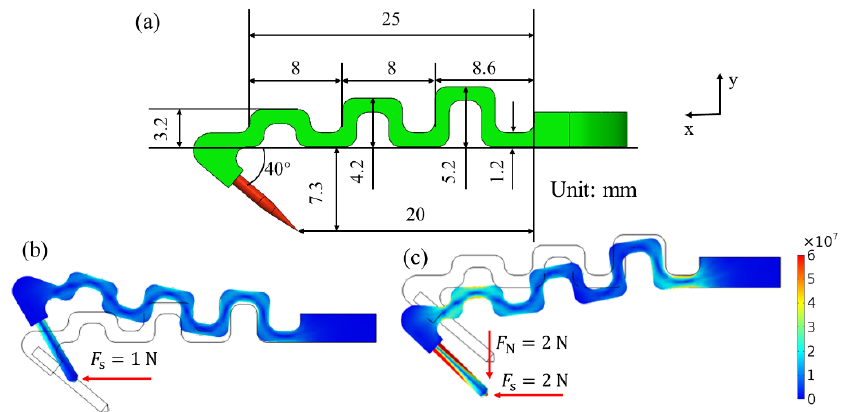
Figure 3. Analysis diagram of flexible structure size, grasping load and pulling load. ( a ) Original dimension of flexible structure. ( b ) Possible stress state during grasping. ( c ) Possible stress state after grasping.